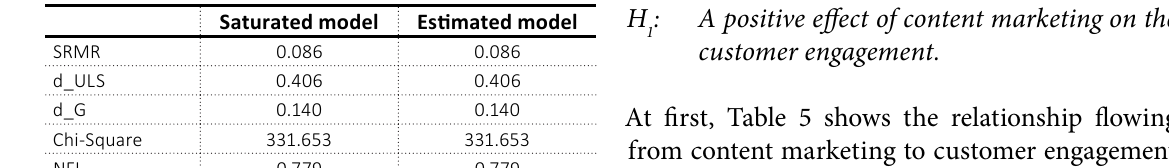
Table 3c. Model fit